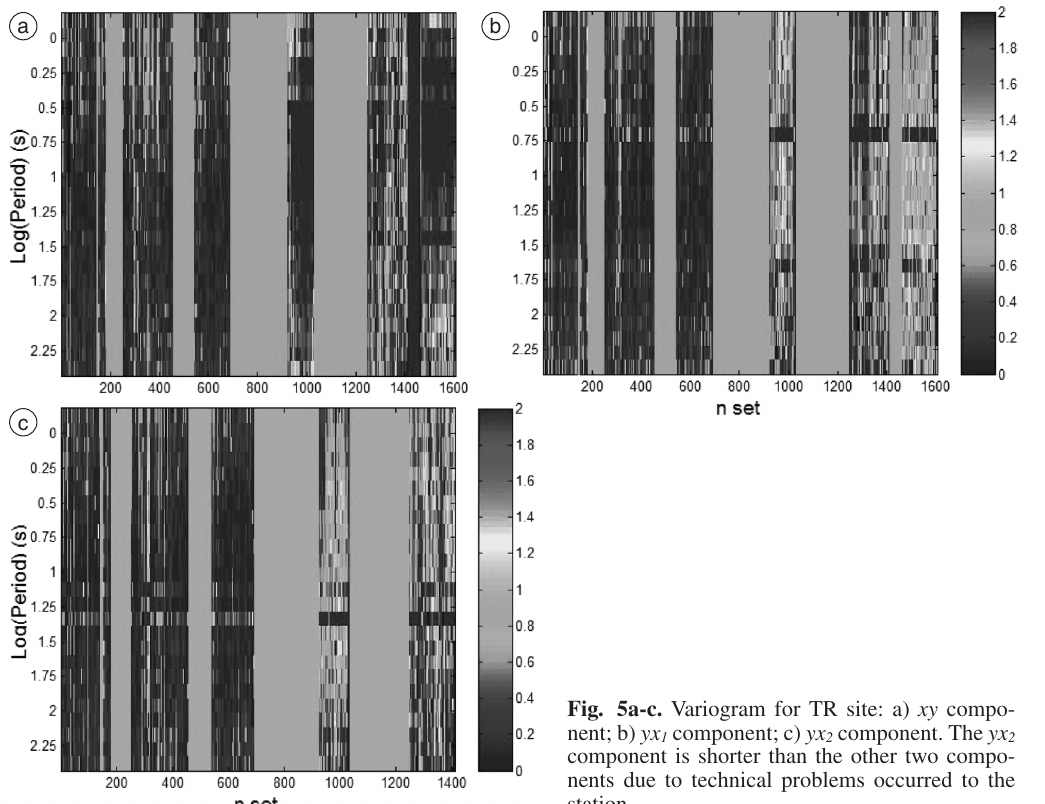
Fig. 5a-c. Variogram for TR site: a) xy compo- nent; b) yx 1 component; c) yx 2 component. The yx 2 component is shorter than the other two compo- nents due to technical problems occurred to the